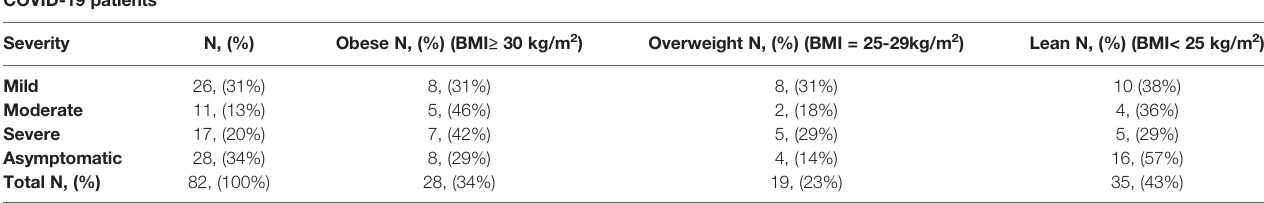
TABLE 2 | Severity and BMI categories of COVID-19